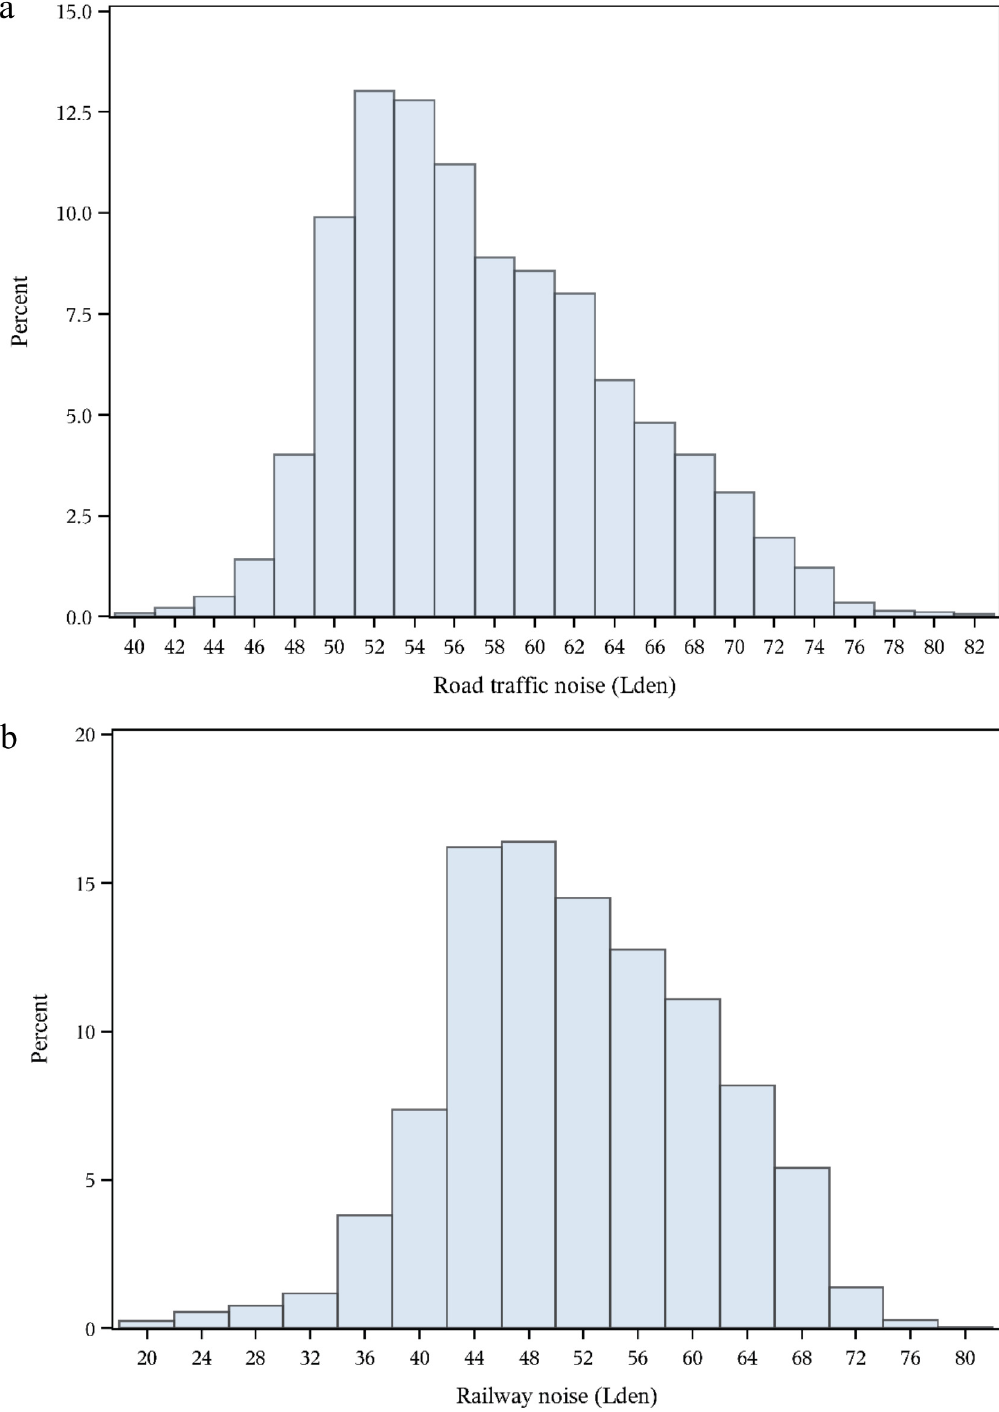
Fig 1. Distribution of residential exposure to road traffic noise (a) and railway noise among exposed participants (b) at the time of enrolment into the cohort.